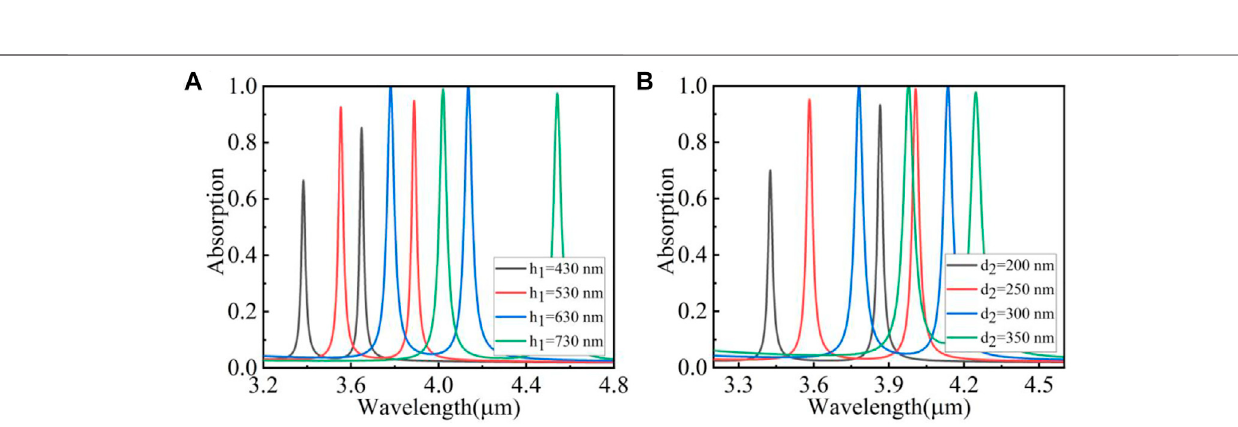
Frontiers in Materials |